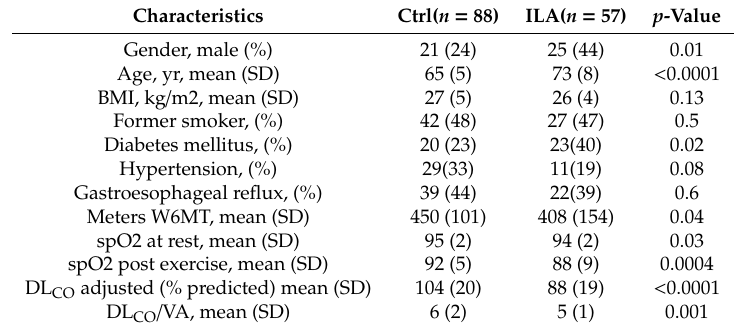
Table 1. Demographic and clinical characteristics of (ILA) and Ctrl from the validation cohort. Characteristics